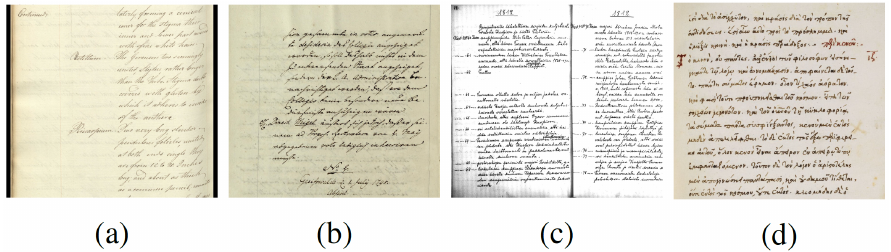
Figure 9. Representative document images from ( a ) English dataset; ( b ) German dataset; ( c ) Finnish dataset; ( d ) Greek